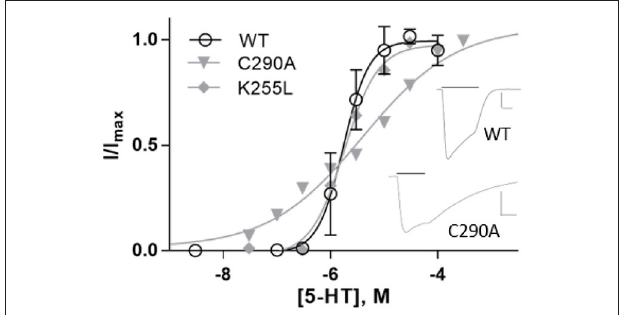
FIGURE 9 | Concentration-response curves of 5-HT 3A receptors in Xenopus oocytes. Data is mean ± SEM, n ≥ 3. Inset: typical current recordings at 3 µ M 5-HT; scale bars are 20 s and 2 µ A.